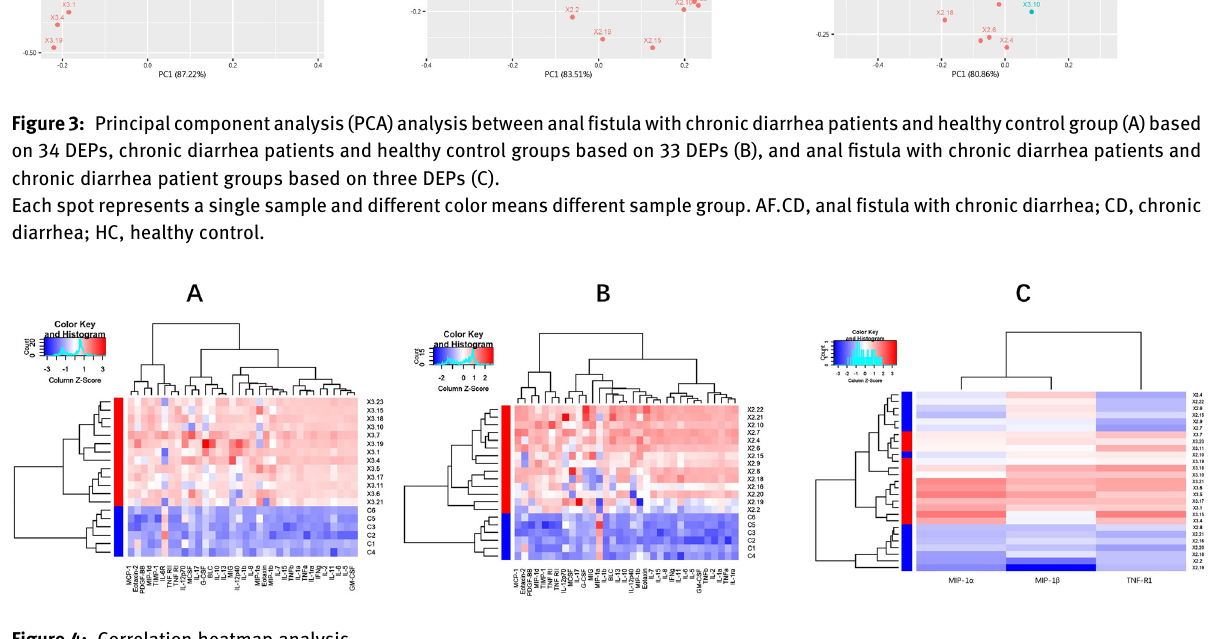
Figure 4: Correlation heatmap analysis. Anal fistula with chronic diarrhea patients and healthy control groups (A) based on 34 DEPs, chronic diarrhea patients and healthy control groups based on 33 DEPs (B), and anal fi stula with chronic diarrhea patients and chronic diarrhea patient groups based on three DEPs (C). Table  : Differential expressedserum proteinsof MIP-  α , MIP-  β and TNF-R  between anal fi stulawit CD patients(n=  ), CD patients(n=  ) and healthy control (n=  ) detected by ELISA.